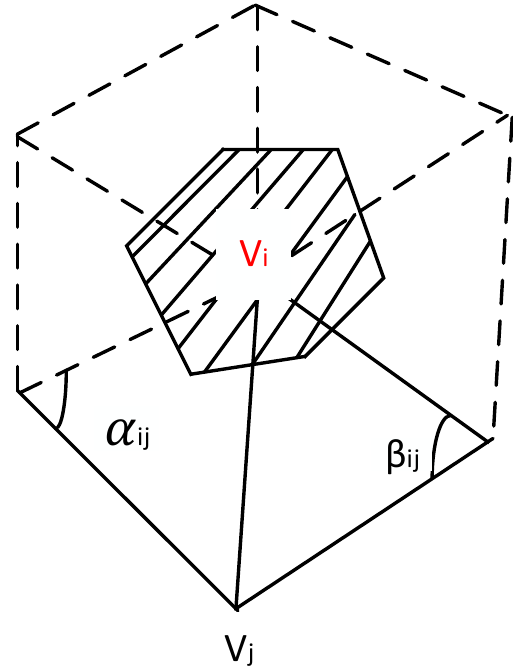
Figure 6. Optimized Laplacian operator model.